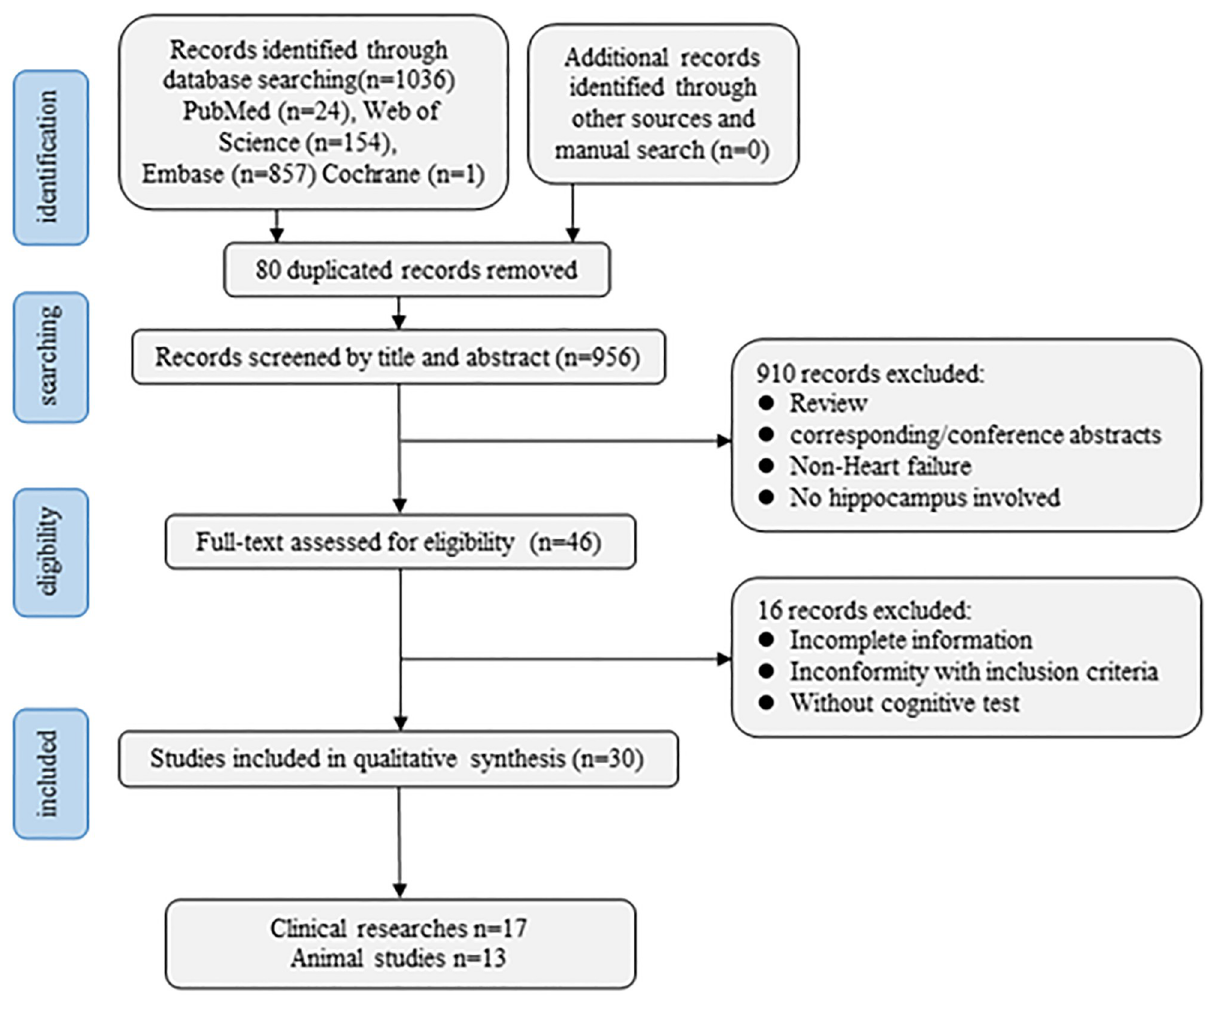
Fig 1. Flowchart of the study selection